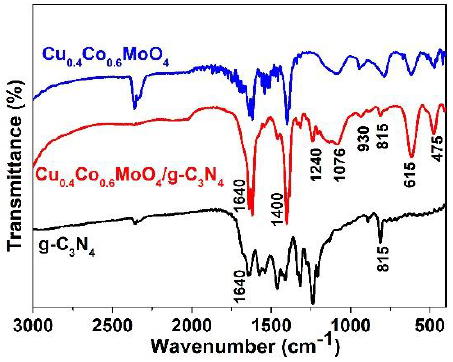
Figure 2. FTIR spectra of Cu 0.4 Co 0.6 MoO 4 , g-C 3 N 4 , and Cu 0.4 Co 0.6 MoO 4 /g-C 3 N 4 .